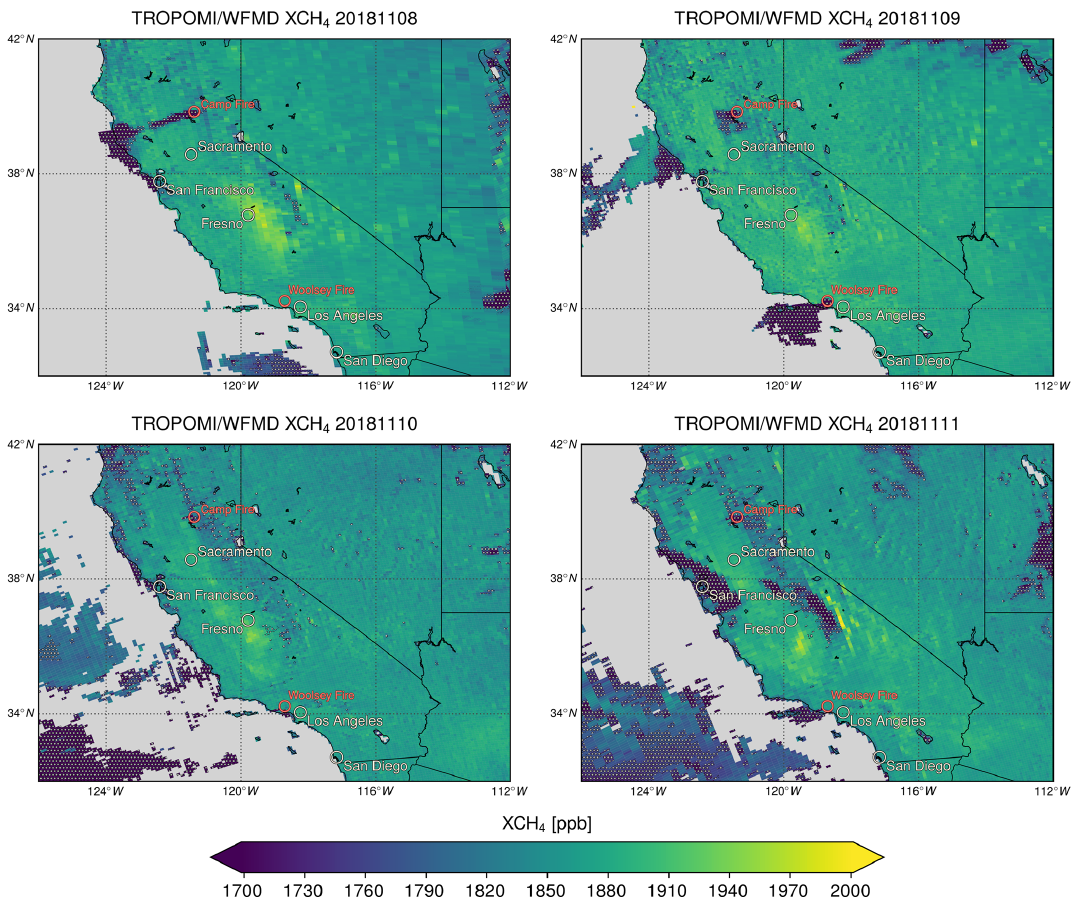
Figure 3. Retrieved methane column-averaged mole fractions from TROPOMI for the same days as in Fig. 1. XCH 4 is used to filter out scenes with significant underestimation (dotted scenes), mainly due to reduced near-surface sensitivity in the presence of clouds or smoke due to shielding of the subjacent partial columns. The Central Valley exhibits combined anthropogenic methane emissions from oil fields and agriculture (Schneising et al.,